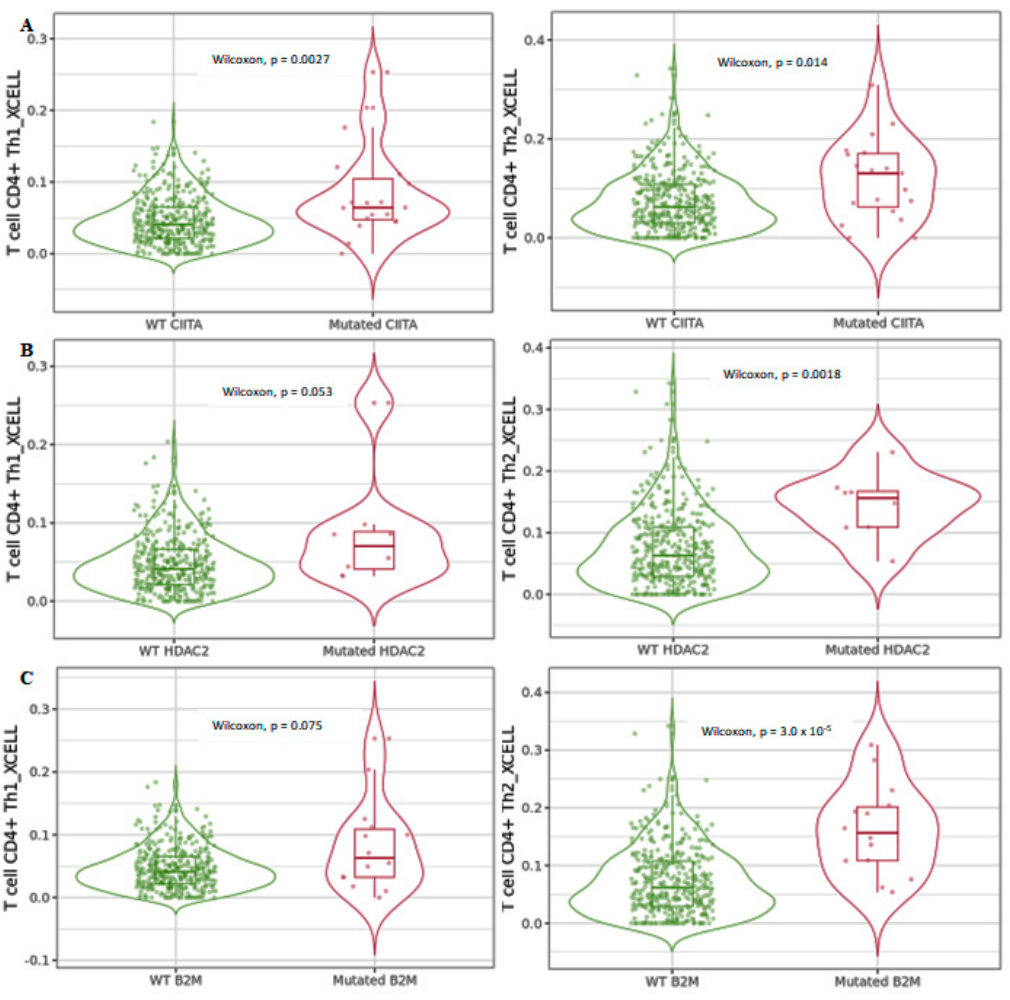
Figure 7. Differential CD4 + Th1 and Th2 T-cell infiltration levels using xCell in mutated ( A ) CIITA , ( B ) HDAC2 , and ( C ) B2M compared to wild-type forms in COAD tumors. Data shown have been purity-adjusted. Data are shown in Log2 scale (fold change): higher level in mutants = p < 0.05, Log2FC > 0; lower level in mutants = p < 0.05, Log2FC < 0; not significant = p > 0.05.